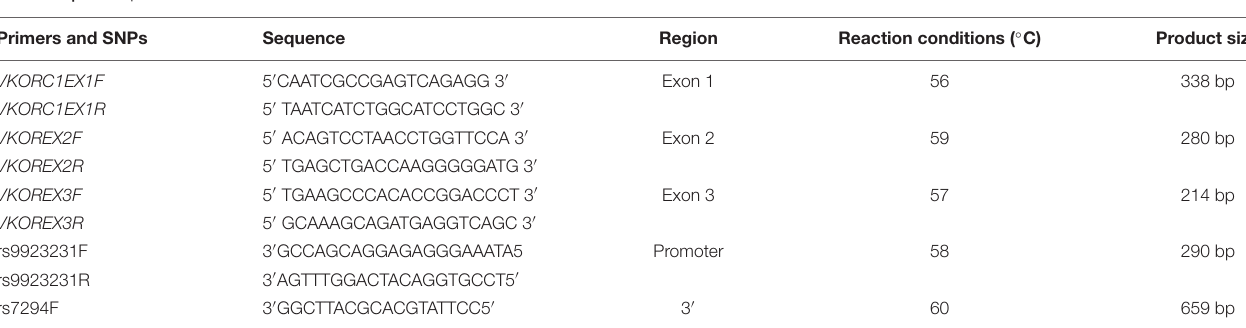
FIGURE 1 | Screenshot of allelic discrimination plot. The three colored dots represent an individual genotype: blue and red dots show homozygotes, whereas green dots show heterozygotes. The encircled dots show not tightly clustered. TABLE 1 | List of